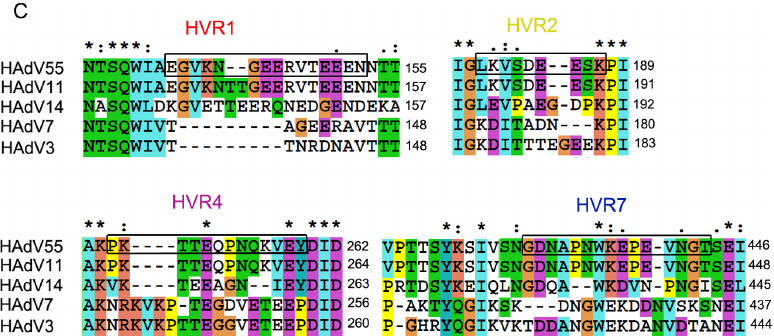
Figure 1. Defining the potential neutralizing epitopes of HAdV55 hexon. ( A , B ) 3D model of HAdV55 hexon and the predicted NAb epitopes in the tower regions ( A : side view, B : top view). A55R1, A55R2, A55R4 and A55R7 were colored by red, yellow, magentas and blue, respectively; ( C ) Amino acid sequence alignment of several HAdV species B hexons. Only four hypervariable regions (HVRs) are shown. The number shows the position of the right side amino acid in the corresponding hexon protein. *, conserved amino acid; : , either size or hydropathy is conserved; . , and both size and hydropathy are conserved. Gaps used to optimize alignments are indicated by dashes. The corresponding amino acid sequences of A55R1, A55R2, A55R4 and A55R7 are marked in boxes.